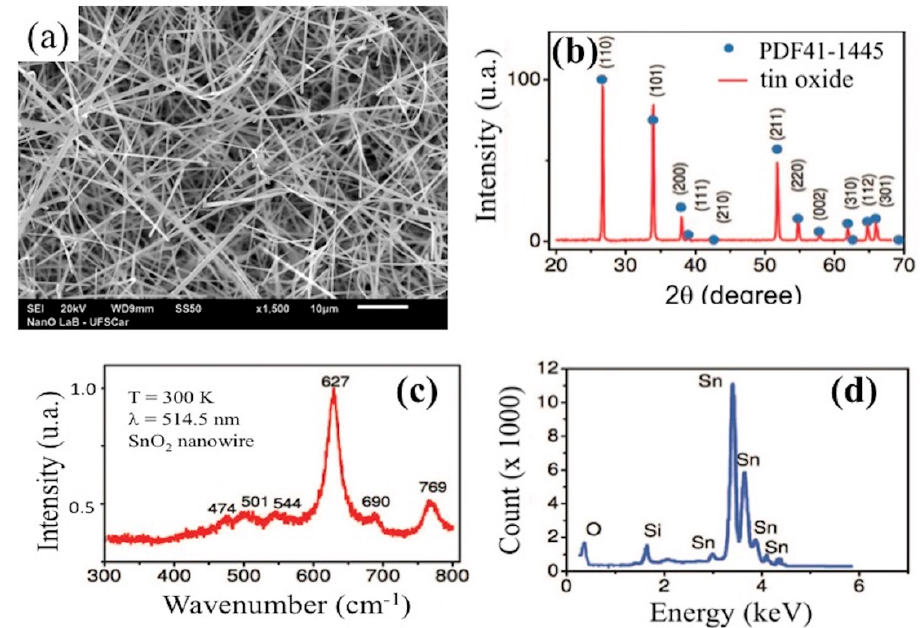
Figure 2. Structural data and chemical composition of the SnO 2 nanowires: ( a ) SEM image of as-grown nanowires exhibiting lengths of tens of micrometers and ( b ) XRD pattern obtained agreeing with JCPDS Card No. 41-1445; ( c ) EDX analysis confirmed that the nanowires are composed only of Sn and O, and ( d ) room-temperature Raman spectra of SnO 2 nanowires.